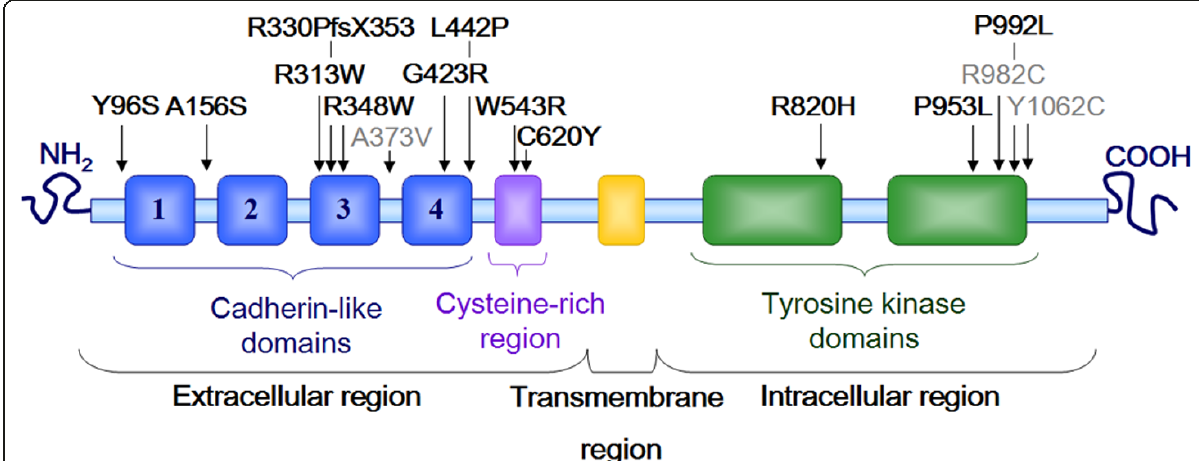
Figure 1 Schematic representation of RET protein . Mutations identified in this study are indicated in the corresponding functional domain. Novel and published mutations are presented in black and grey,